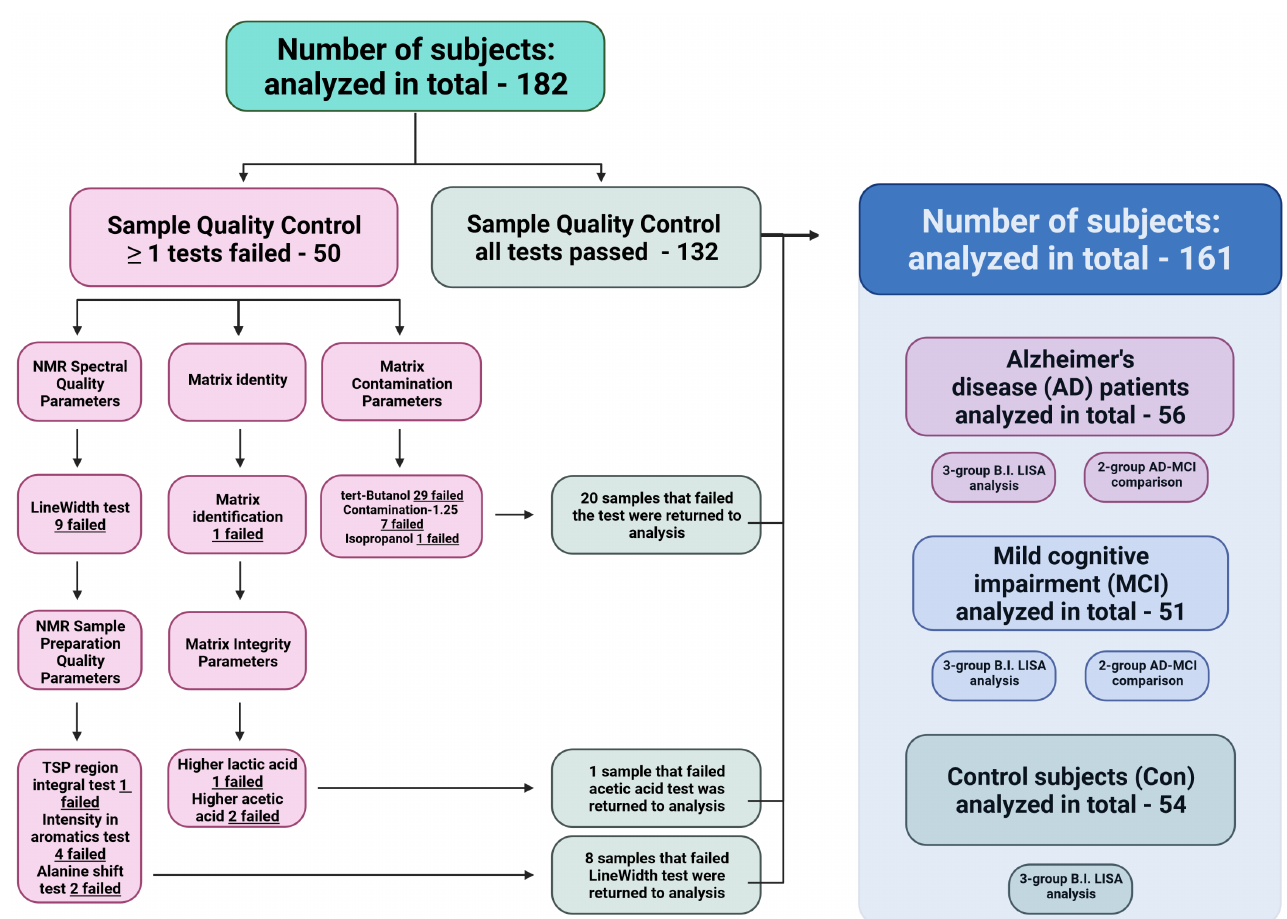
Figure A1. Tree diagram of QC with the representation of samples returned to the statistical analysis of the current study.